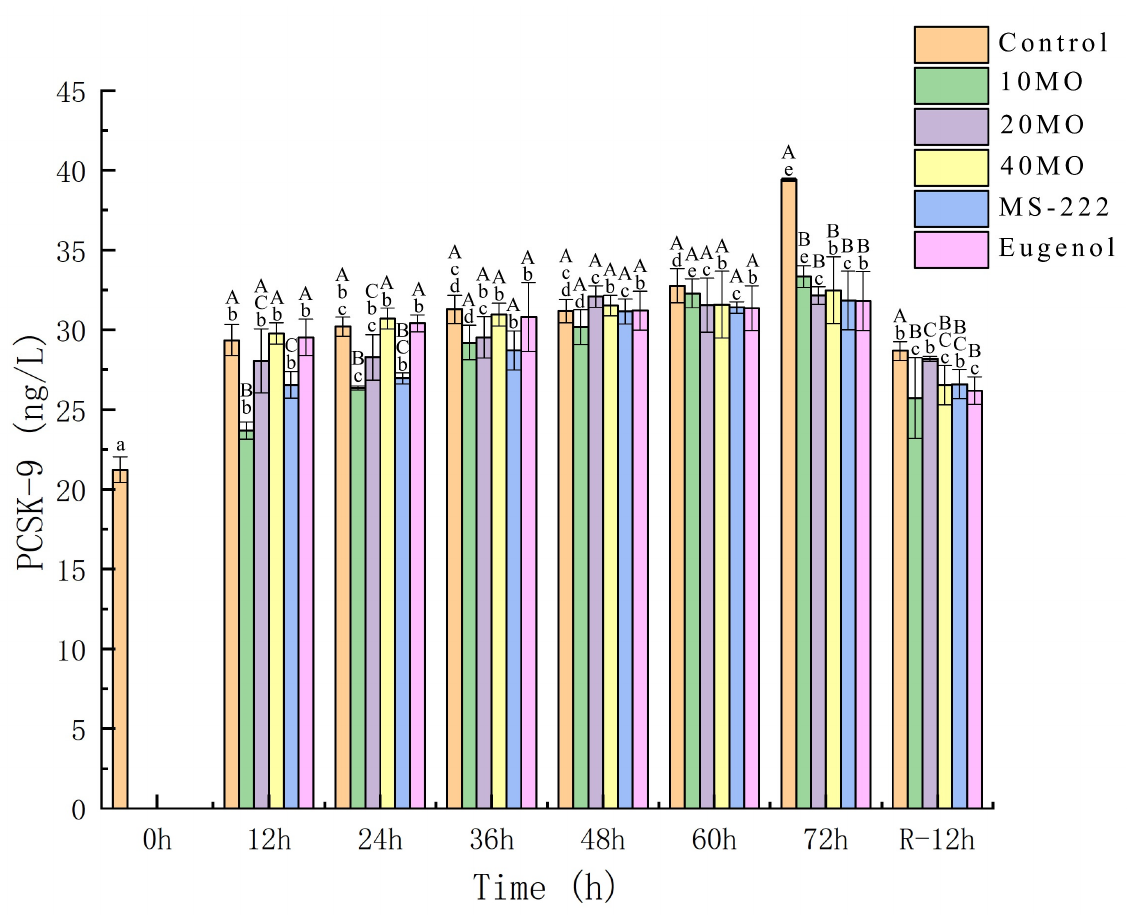
Figure 2. The activity changes in PCSK-9. 10 MO: 10 mg/L MOEO, 20 MO: 20 mg/L MOEO, 40 MO: 40 mg/L MOEO, MS-222: 30 mg/L MS-222, eugenol: 20 mg/L eugenol, control: no agent addition. Vertical bars indicate the standard deviation; Means with different lowercase letters indicate a significant difference between the time intervals within each group ( p ≤ 0.01) while different capital letters indicate significant differences between the groups in each time interval ( p ≤ 0.01).